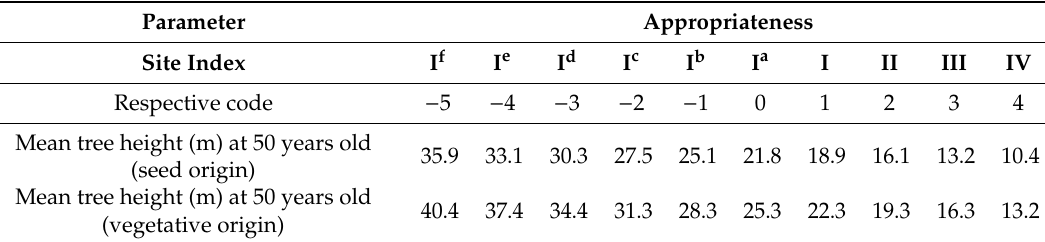
Table 2. Encoding system for site indexes.